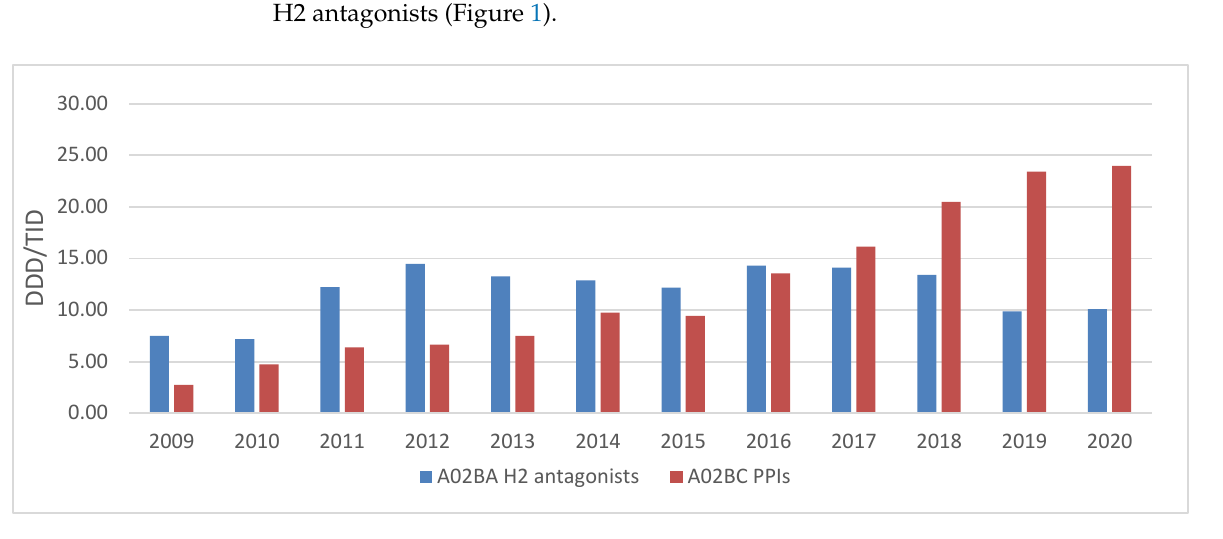
Figure 1. The utilisation of medicines from A02BHA (H2 antagonists) and A02BC (PPIs) groups at the IV level according to ATC classification, expressed in DDD/TID.